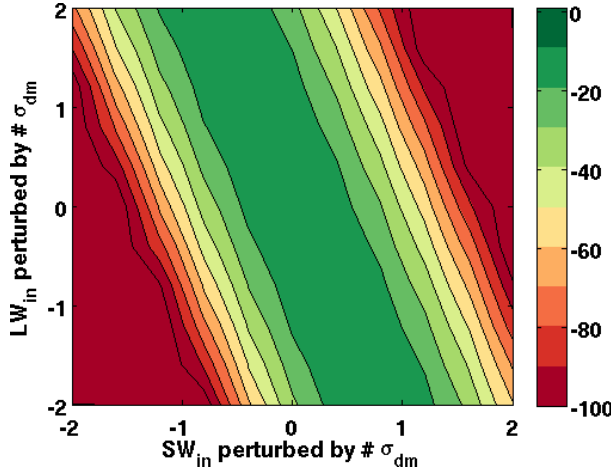
Fig. 12. Vertically averaged Brier Skill Scores (BSS) of water tem- perature profiles (0–60m; 1m vertical increment) at Ishungu from a set of simulations with SW in and LW in perturbed by proportions of their respective standard deviations of daily mean values ( σ dm )